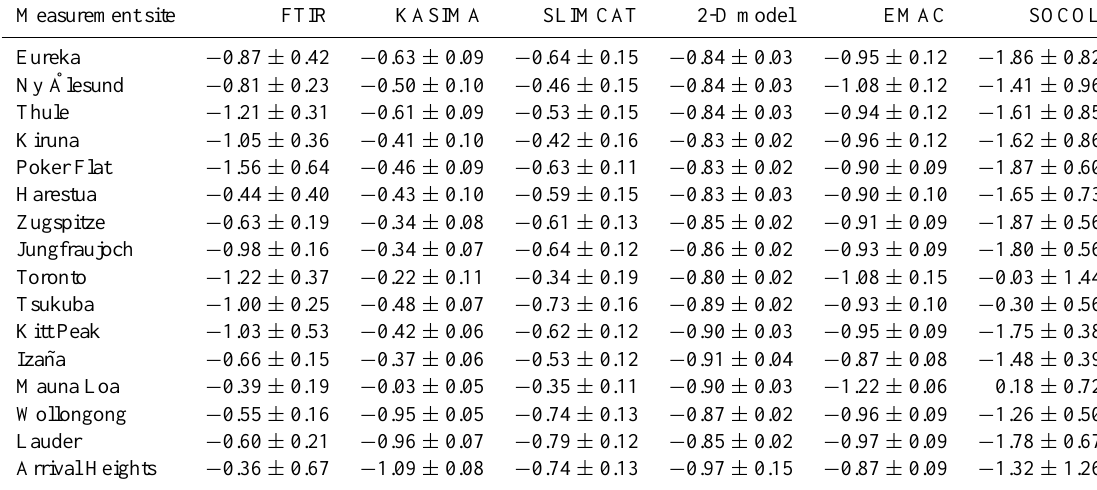
Table 4. HCl trend in% per year between 2000 and 2009, calculated by fitting a linear function combined with a first (sites poleward of 70°) or third order Fourier series to the data. The error bars were determined with the bootstrap method.